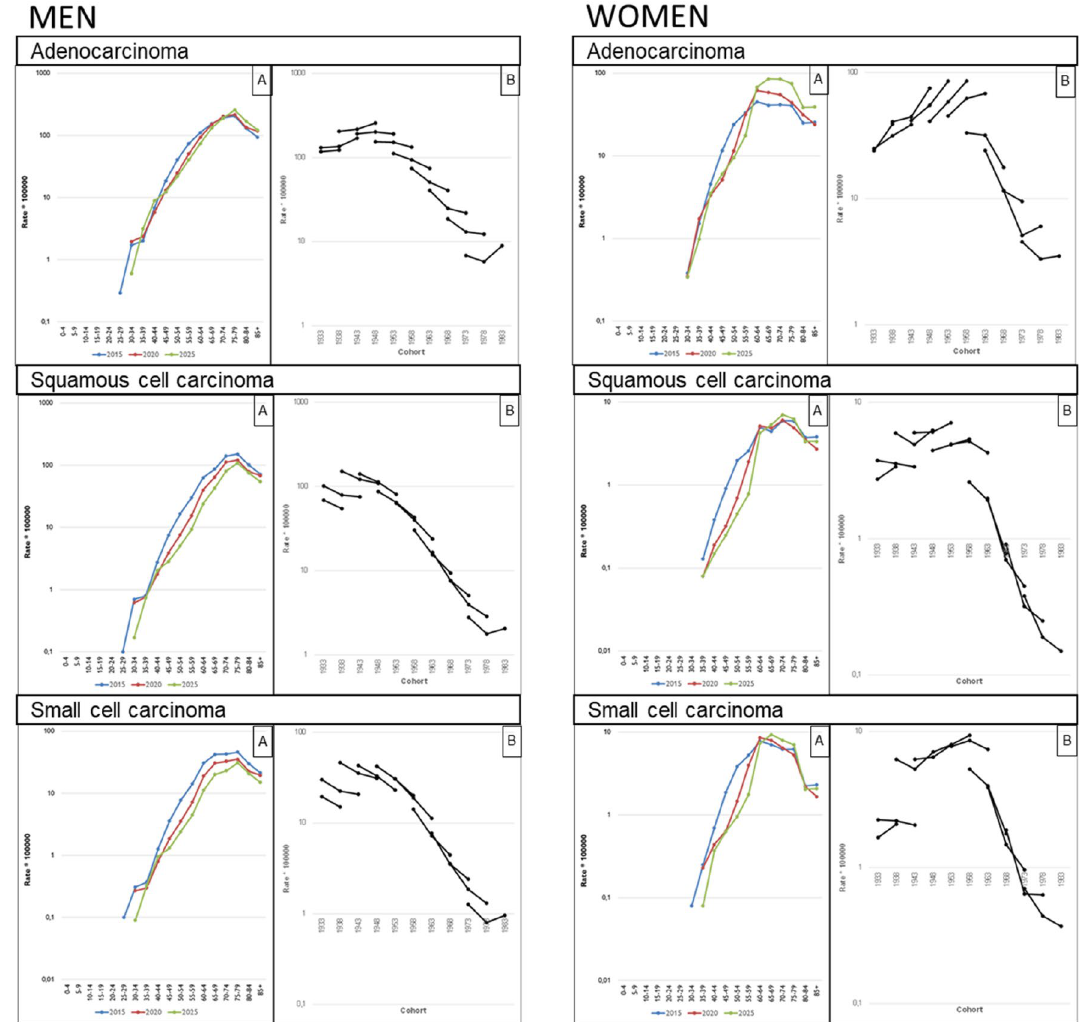
Figure 3. Time trends and projections of lung cancer by histology type in Catalonia up to 2025: ( A ) Age- specific incidence rates of lung cancer in 2020 (red) and 2025 (green) with respect to the reference year 2015 (blue). ( B ) Age-specific incidence rates by birth cohort. Note: These figures resulted from an age-period-cohort model by histological type and